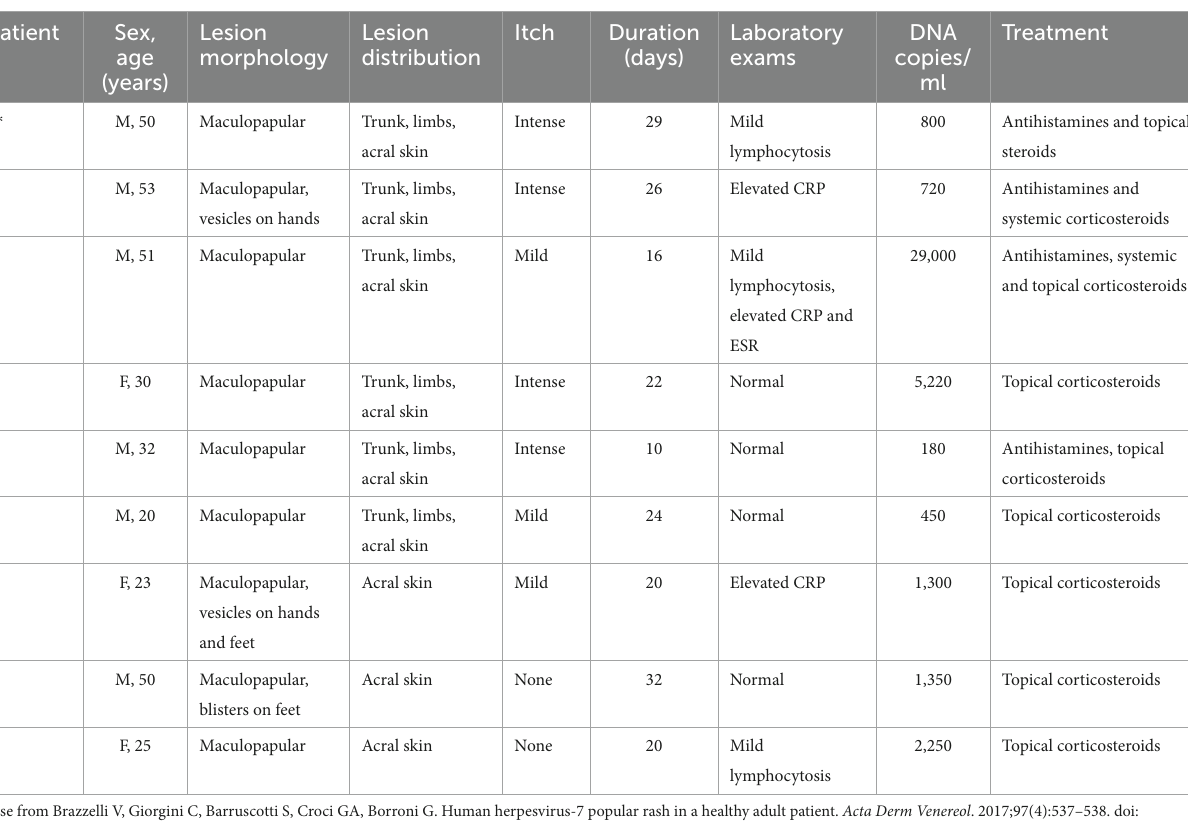
TABLE 1 Clinical data of the patients.